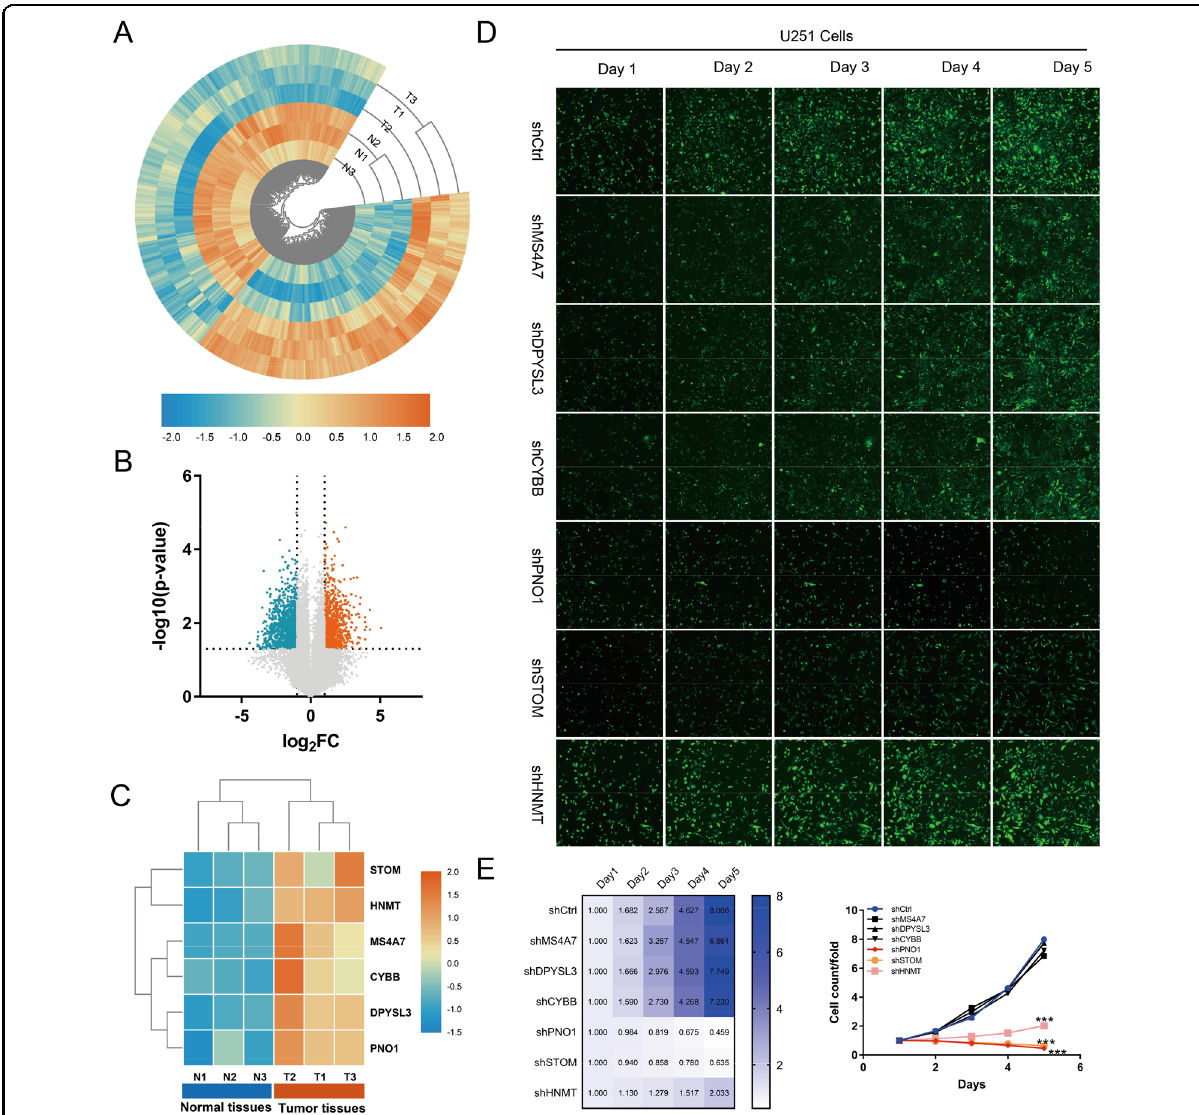
Fig. 1 mRNA microarray analysis and high-content screening identify a potential role of PNO1 in GBM. mRNA microarray analysis was used to identify differentially expression genes (DEGs) between three GBM tissues (T) and three normal tissues (N). High-content screening and target-shRNAs delivered by lentivirus, were used to assess the effects of six selected genes on glioma cell growth. Hierarchical clustering plots ( A ) and volcano plots ( B ) were used to show the DEGs from mRNA microarray analysis (|logFC | >1 and FDR < 0.05). C Heatmap of six selected DEGs. D Representative images of U251 cell growth are shown. U251 cells were infected with lentivirus encoding shRNAs against these 6 DEGs. E Heatmap(left) and growth curves (right) showing the growth of U251 cells. Data were normalized to cell number on day 1 and are represented as fold change. ***P < 0.001 versus